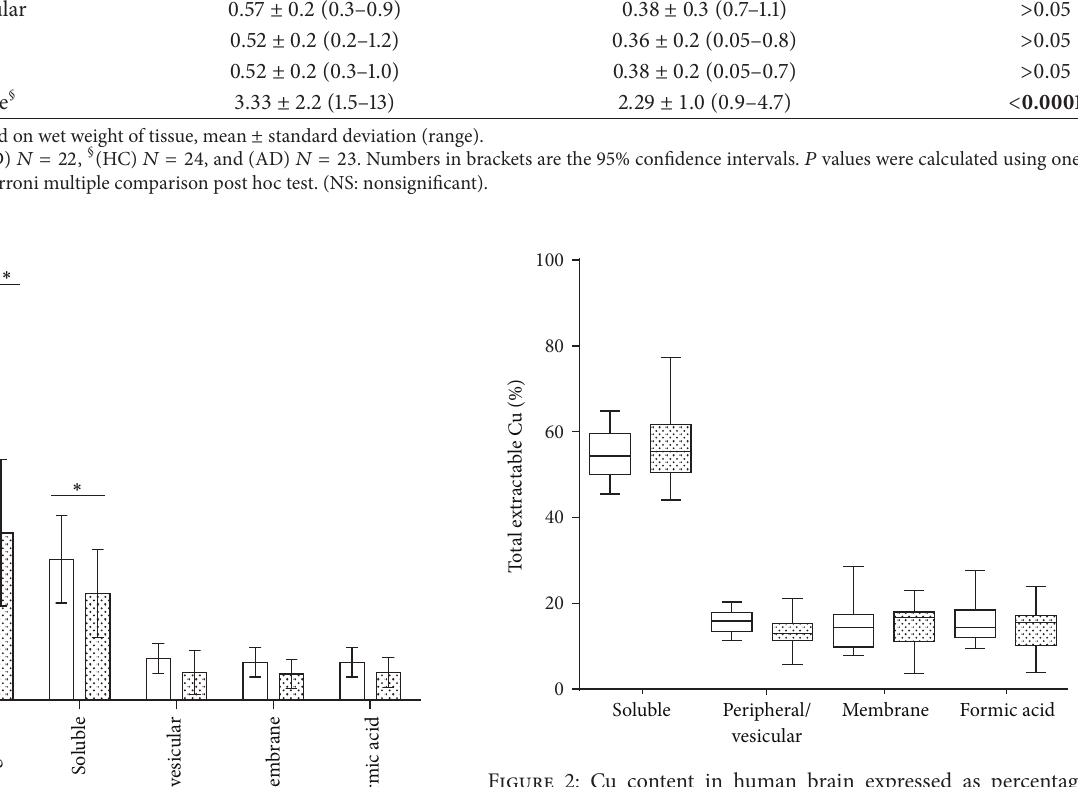
Figure 2: Cu content in human brain expressed as percentage distribution. The percent distribution of Cu extracted from human frontal cortex in the brain is conserved in AD and HC (total pooled). Box and whisker plots show the range, interquartile range, and median values. No significant difference was observed in the percentage of Cu in each of the corresponding fractions. Between 50–60% of the total Cu in human brain tissue is extractable in the soluble phase. No significant difference was observed between HC (clear boxes) and AD (filled